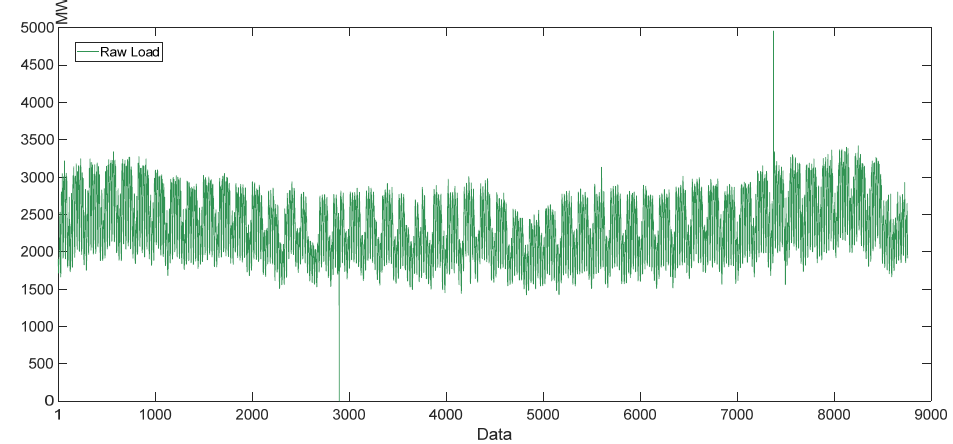
Figure 1. Load value of a region in Denmark in 2019.